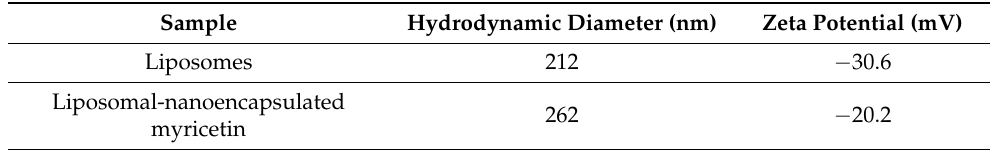
Table 1. The hydrodynamic diameter and zeta potential of liposomes and liposomal-nanoencapsu- lated myricetin.